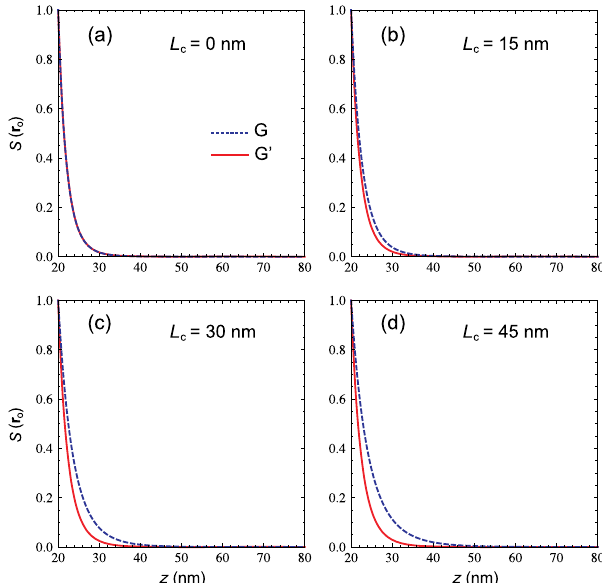
FIG. 6. Symmetries of near-field Raman scattering in the TST configuration. The yellow spots represent the top view of the tip (axis along the z direction) with the graphene lattice underneath 5. Distance dependence of the TST signal for the G and G 0 (lying in the xy plane). In (a), the ⊗ symbol represents the tip bands. Panels (a-d) are evaluated for different correlation lengths dipole induced by the incident field. The green arrows represent L : 0, 15, 30, and 45 nm, respectively. In all cases, we used c the x and y in-plane components of the electric field generated by ~ f 3 . The signal S ð r z 20 nm, 0 Þ is normalized to 1 for the tip dipole at the graphene lattice. The respective induced e ¼ min ¼ which corresponds to the closest tip-sample distance for Raman dipoles in the graphene plane are represented by the red r 15 nm, considering that the minimal distance between arrows in (b-d) for the modes with A 1 , E 2 , and E 2 symmetries, tip ¼ g 1 g 2 0 , the curves the tip apex and the sample is about 5 nm. For L → ∞ ), respectively. By considering the fully coherent case ( L c ¼ c for G and G 0 coincide. This case corresponds to an incoherent the scattered fields generated by the A 1 Raman dipoles add addition of the Raman response in different points of the constructively at the tip apex, generating a strong induced dipole graphene lattice. As L increases, interferences between neigh- at the tip [represented by the ⊗ symbol in (b)]. On the other hand, c boring lattice points which are symmetric with respect to the the field generated by the Raman dipoles interfere destructively at the tip apex for the E 2 and E 2 symmetries [(c) and (d), lateral location of the tip give rise to a distance dependence that is g 1 g 2 different for the G and G 0